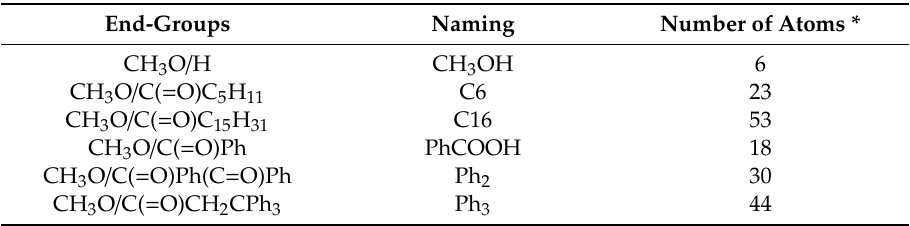
Table 1. Naming convention for the functionalized polymers. End-Groups Naming Number of Atoms